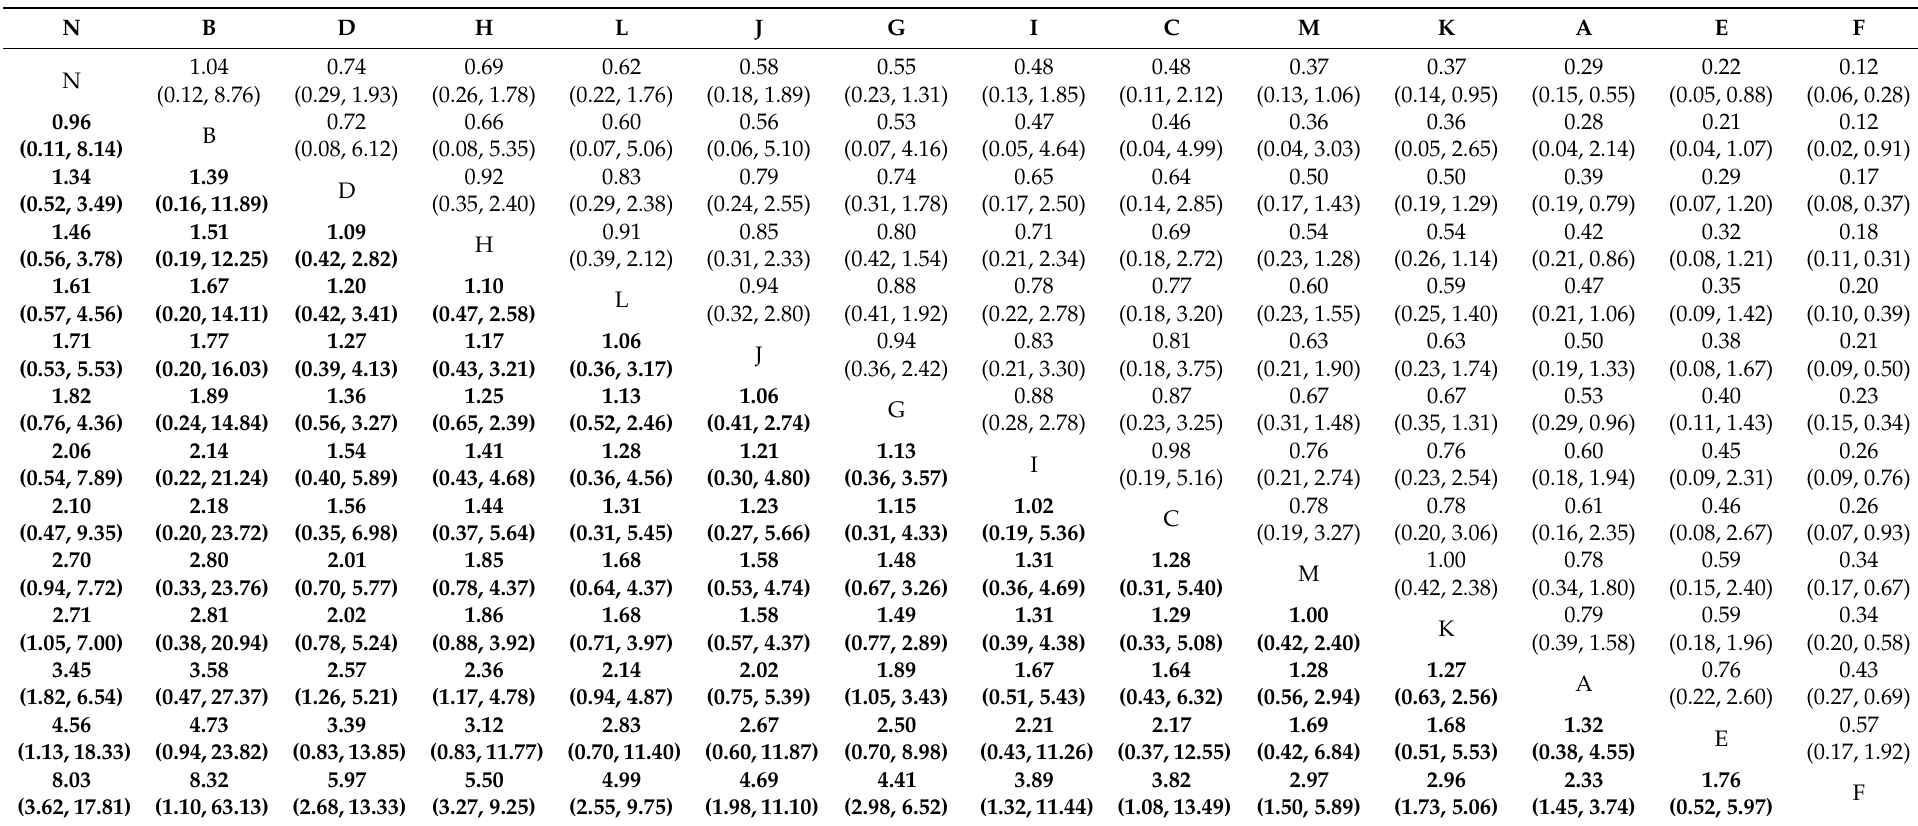
Table 2. Network analysis results of the total effective